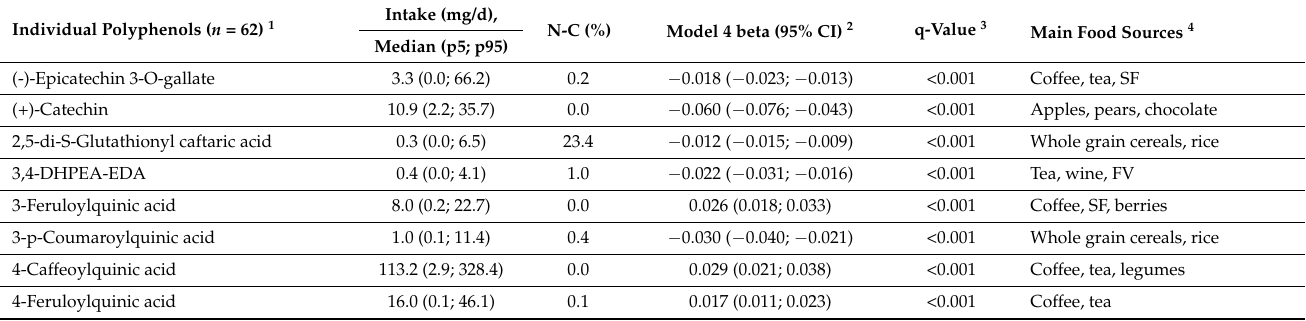
Table 2. Change in body weight over 5 years according to baseline polyphenol intake in 349,165 par- ticipants from the EPIC-PANACEA